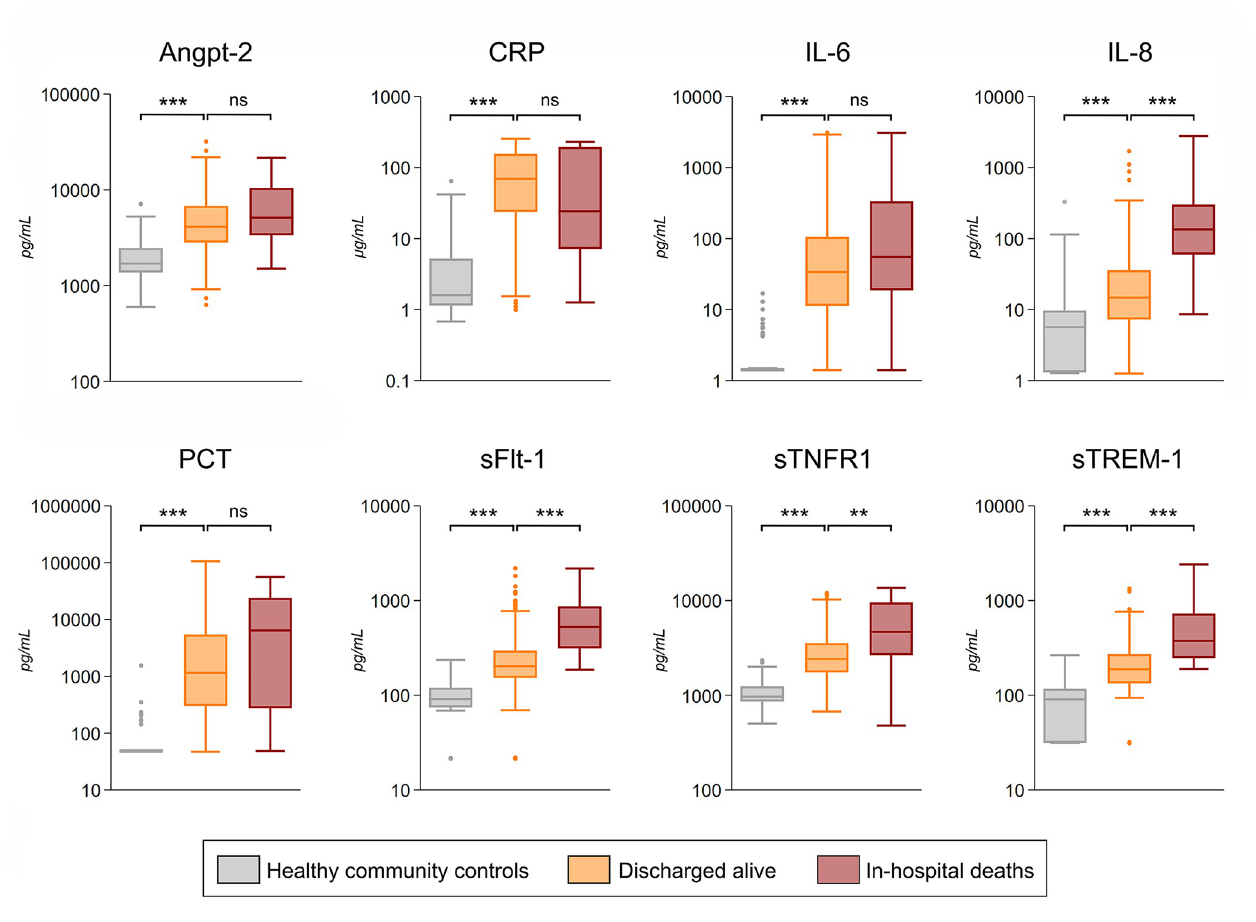
Fig 1. Plasma concentrations of immune and endothelial activation biomarkers at study enrolment in healthy community controls, pneumonia cases discharged alive, and pneumonia cases who died during hospital stay. Boxplots with median and interquartile range. Whiskers represent one and a half times the interquartile range, and outliers are plotted as individual points. Concentrations are in pg/mL, except CRP in μ g/mL. p-values were computed using the Mann-Whitney U test. � p < 0.05, �� < 0.01; ��� p < 0.001; ns: non-significant. Abbreviations: Angpt-2 (angiopoietin-2), CRP (C-reactive protein), IL-6 (interleukin-6), IL-8 (interleukin-8), PCT (procalcitonin), sFlt-1 (soluble fms-like tyrosine kinase-1), sTNFR1 (soluble tumor necrosis factor receptor), sTREM- 1 (soluble triggering receptor expressed on myeloid cells 1).